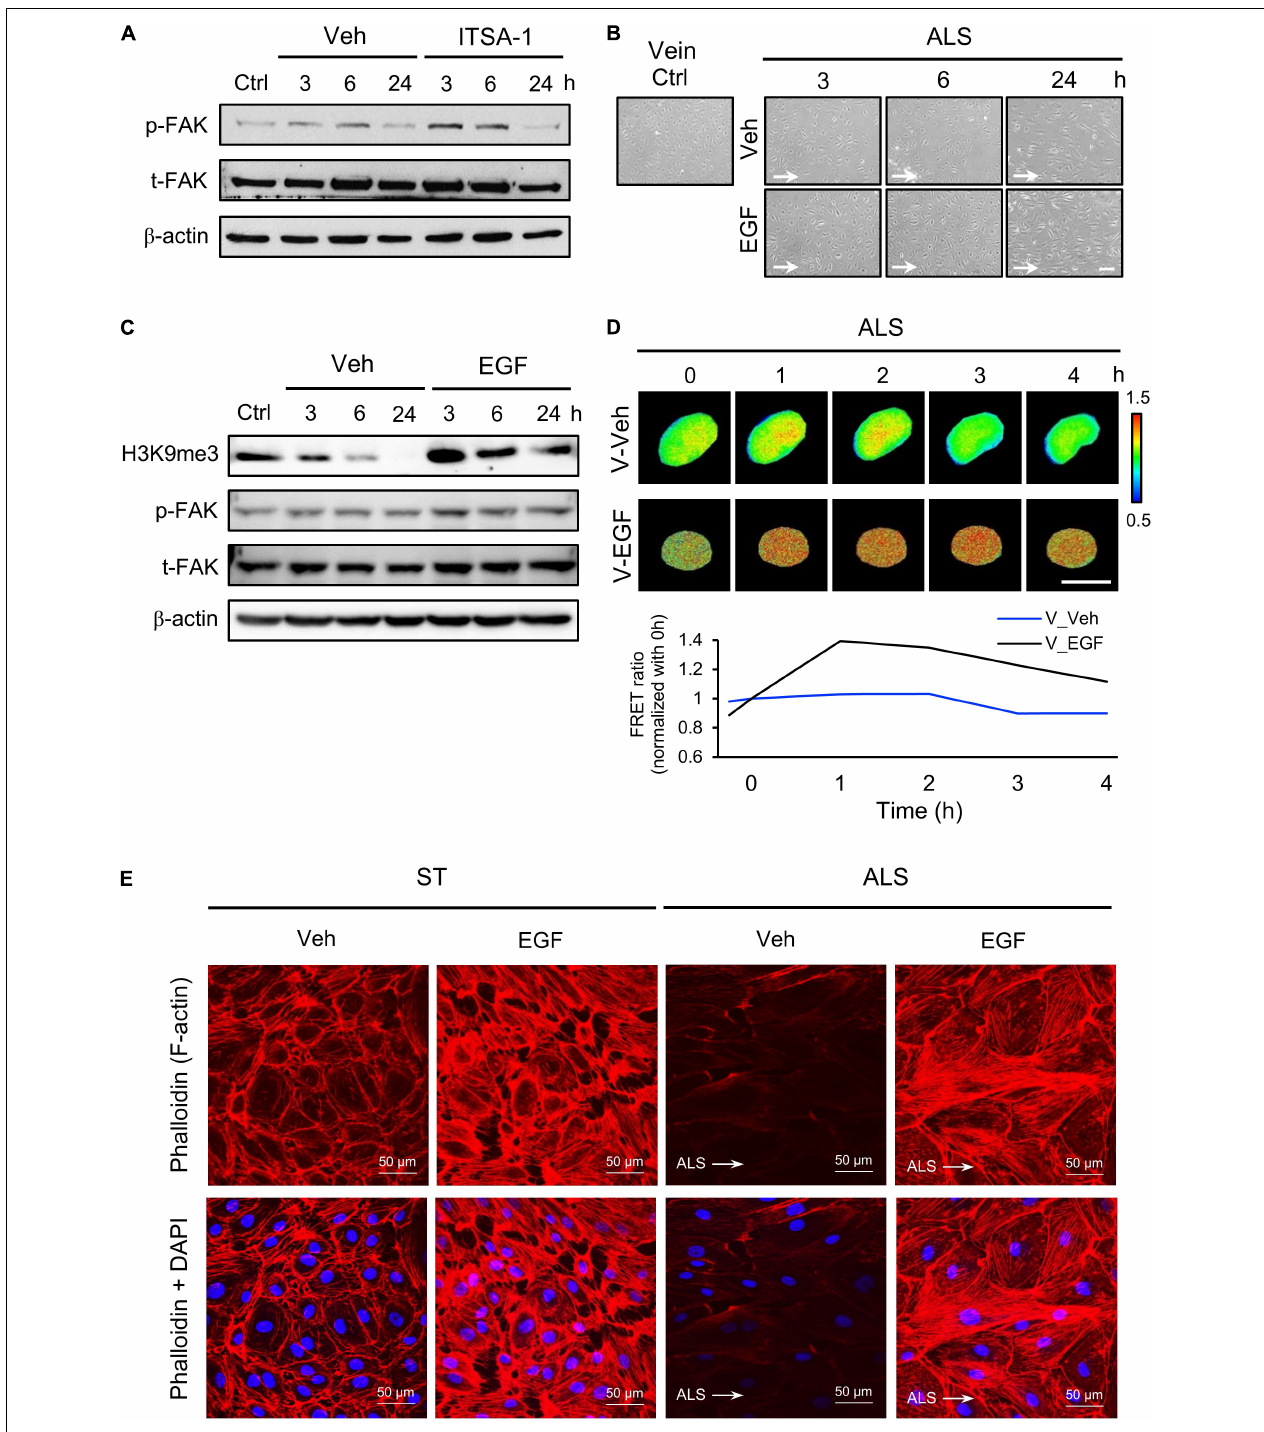
FIGURE 6 | Protective effect of EGF on preventing ALS-induced EC inflammation. (A) Western blotting analysis for activating H3K9me3 by treating ITSA-1 in vEC (HSVECs); the expression of p-FAK was increased after ALS stimulation. (B) Treating EGF (100 ng/ml) in HSUVEs prevented the cell peel-off and the cells were parallel to the flow direction under ALS. (C) Protein expression was analyzed by using conventional Western blotting assay against H3K9me3, p-FAK, and t-FAK. The expression of H3K9me3 was gradually increased by raising the expression of p-FAK in EGF-treated HSVECs under ALS. (D) To validate the flow regulation of H3K9me3 in EGF-treated HUVECs, the results also confirmed that EGF induced H3K9me3 over the time course of 4 h in H3K9me3 biosensor-transfected HSVECs under ALS. (E) Alexa fluor 546-Phalloidin staining was used to determine the expression of F-actin on vECs with or without EGF treatment under ALS for 24 h. Nuclei were stained with DAPI (blue). Scale bar in cell phase images = 200 µ m. Scale bar in FRET images = 20 µ m. Data were represented as mean ± SEM. Arrow indicated the flow direction of ALS (left to right).